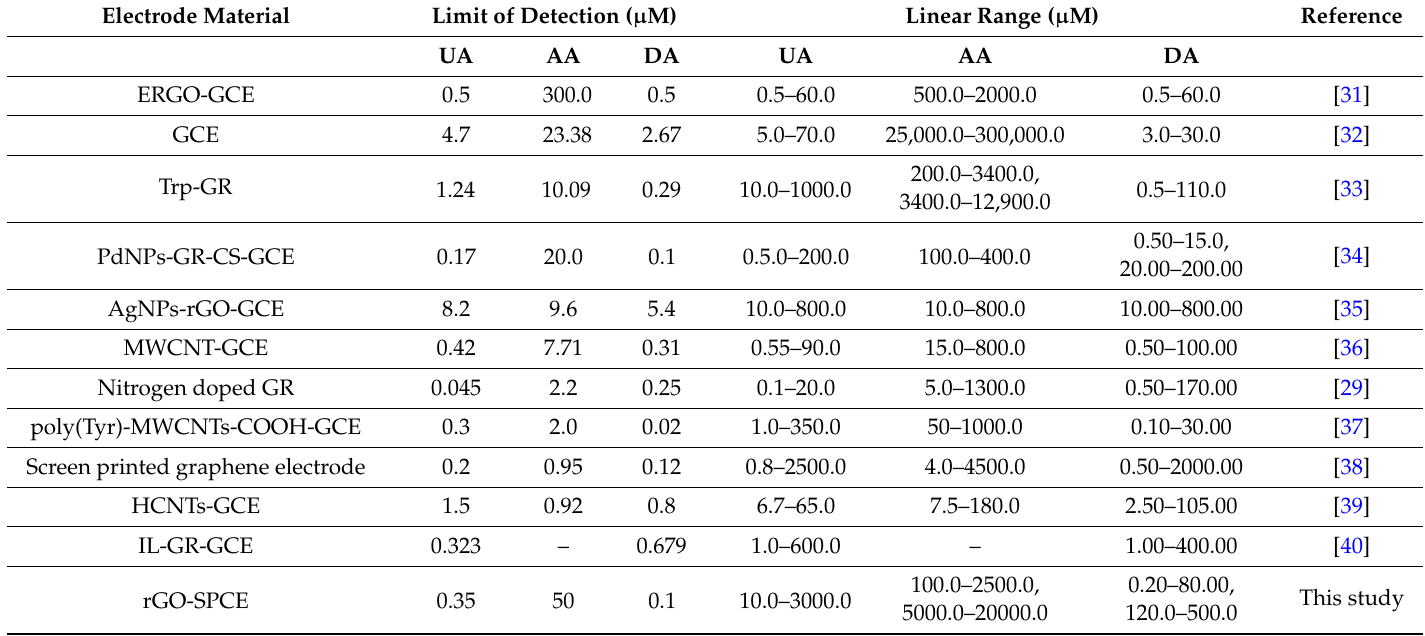
Table 2. Comparison of the analytical performance characteristics of UA, AA and DA